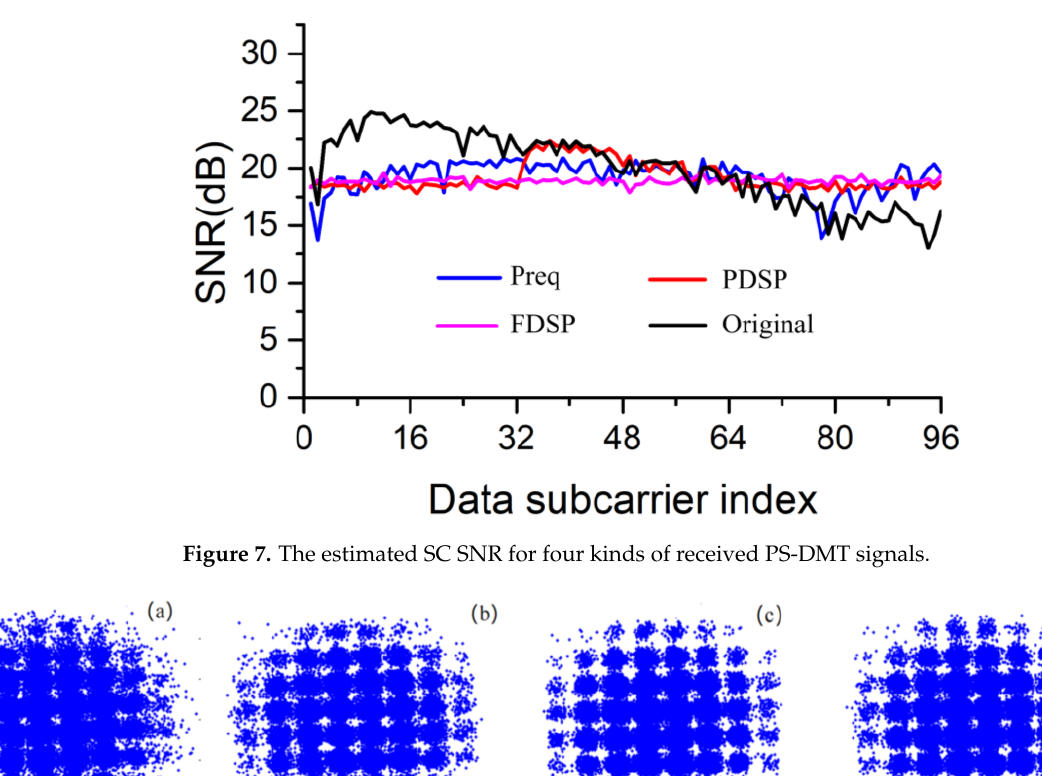
Figure 8. The recovered 64 QAM constellations for ( a ) original scheme, ( b ) pre-equalization, ( c ) WHT-based FDSP and ( d ) fast WHT-based PDSP.